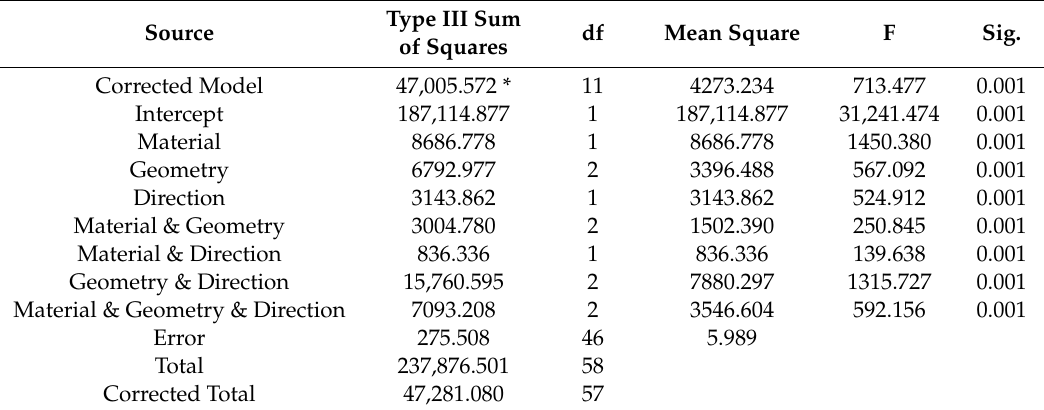
Table 5. Results of the ANOVA analysis for elongation at